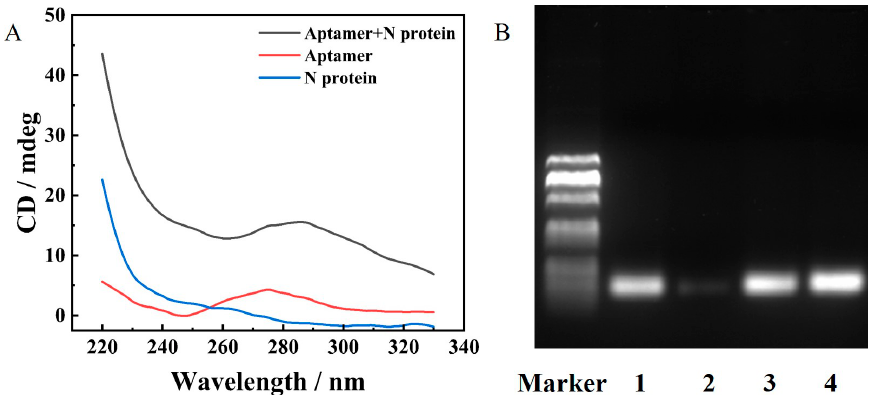
Figure 4. ( A ) CD spectra of aptamer after incubation with N protein at 37 °C for 30 min (black curve), aptamer (red curve), and N protein alone (blue curve). The concentration of N protein and aptamer was equal to 1 μ M. ( B ) Agarose gel electrophoresis. The concentration of N protein, ap- tamer, and Exo I was 600 nM, 400 nM, and 240 U/mL, respectively.